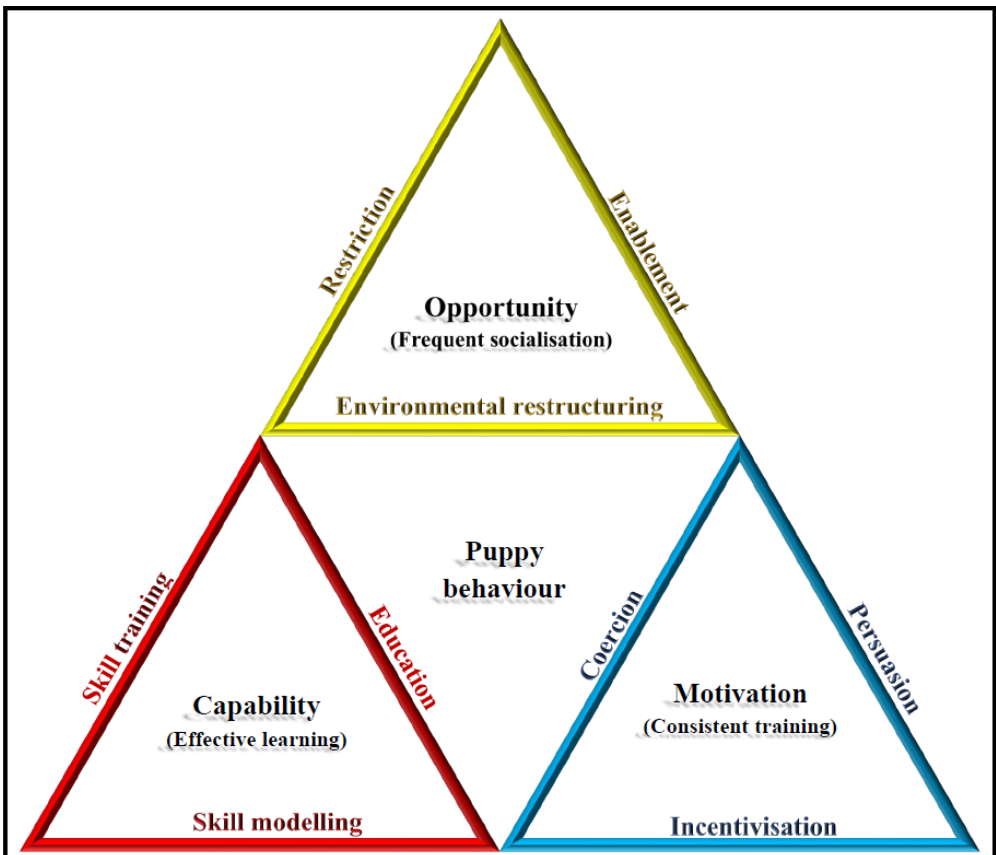
Figure 2. The Triple Triangle (3T) Model for Assistance Dog Puppy Raising.